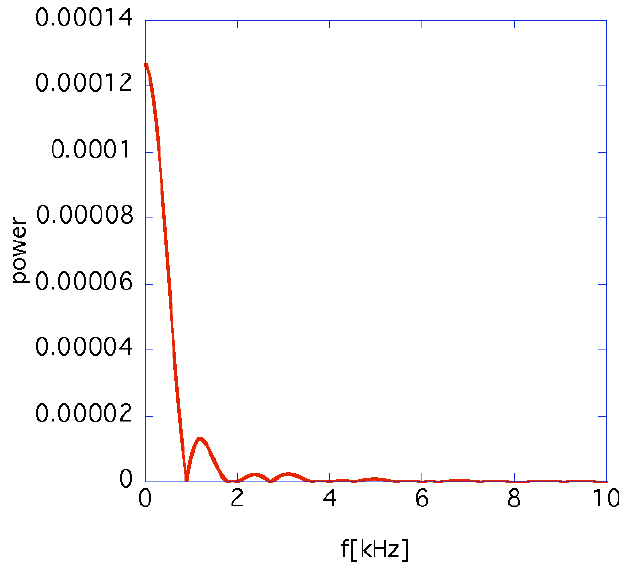
FIG. 18. (Color) Power spectrum for the field pattern B ð t Þ rep- resented in Fig.